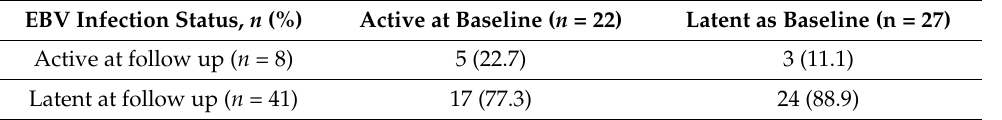
Table 2. EBV infection status during the follow up. EBV Infection Status, n (%) Active at Baseline ( n = 22) Latent as Baseline (n = 27) Active at follow up ( n = 8) 5 (22.7) 3 (11.1) Latent at follow up ( n = 41) 17 (77.3) 24 (88.9) From eight (15.7%) samples positive for viral DNA at baseline, only one sample (2.0%) was still positive at six months ( p = 0.219). In addition, one patient became EBV DNA positive after six months, although his result was negative at baseline.